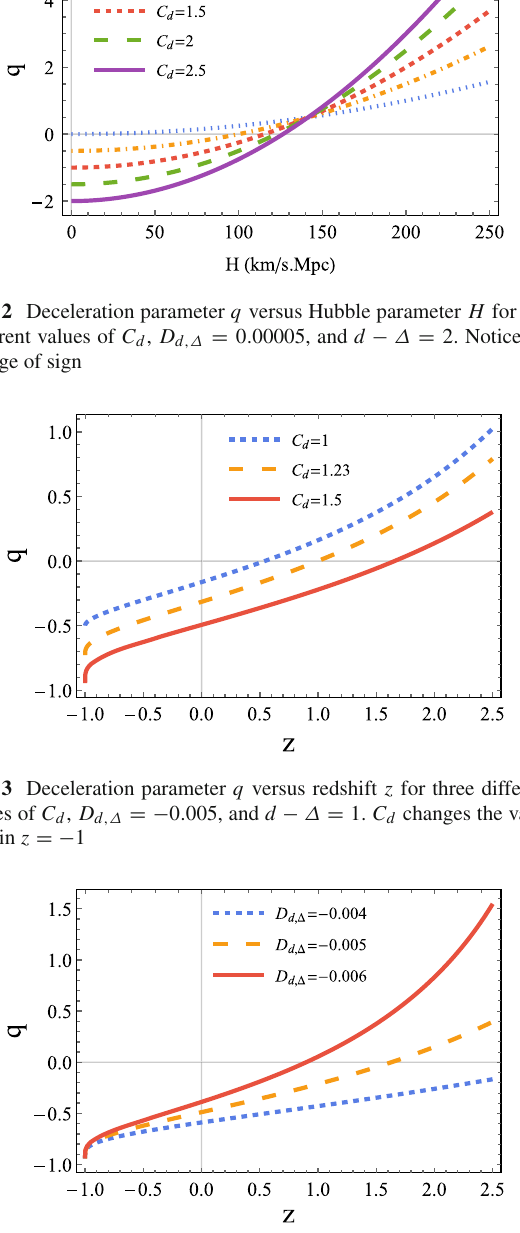
Fig. 4 Deceleration parameter q versus redshift z for three different values of D d ,Δ , C d = 1 . 5, and d − Δ = 1